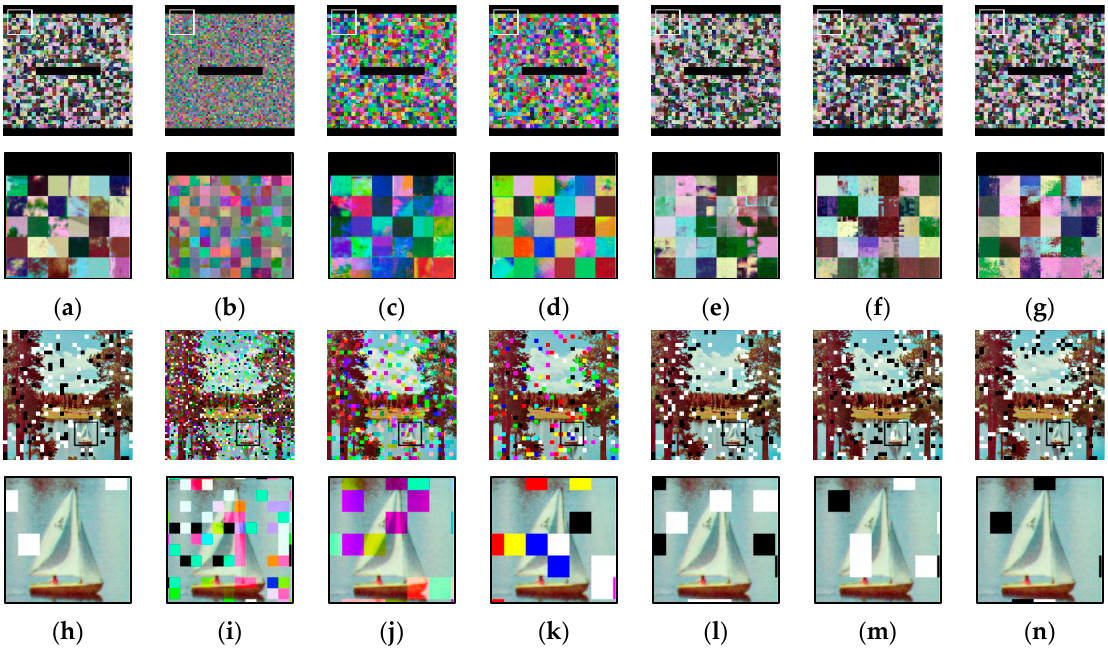
Figure 21. The CPE methods robustness against the data loss a tt ack. ( a – g ) The cipher images given in Figure 20b–h with the data loss a tt ack. Their corresponding recovered images are shown in ( h – n ). For be tt er visual inspection, the boxed region in each image is enlarged and shown below them .